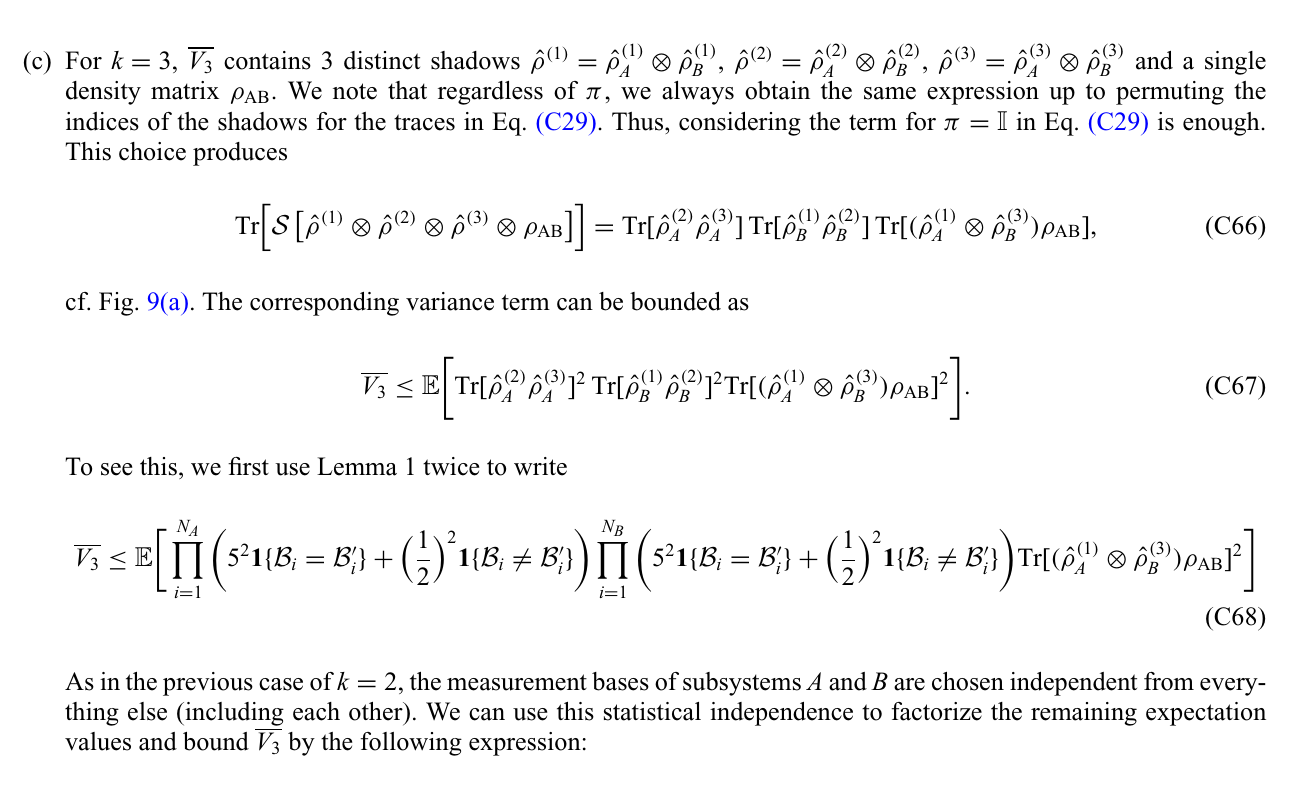
FIG. 8. The diagrammatic expression of the relevant terms for k = 2: (a) Tr[ S ( ˆ ρ ( 1 ) ⊗ ˆ ρ ( 2 ) ⊗ ρ ⊗ 2